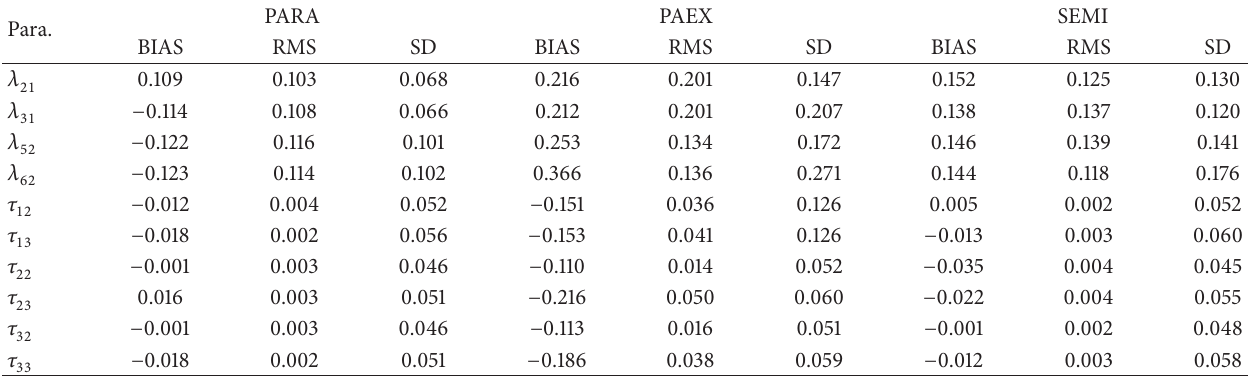
Table 2: Summary of the estimates under the parametric, partly exchangeable, and semiparametric approaches in analyzing simulated data: normal